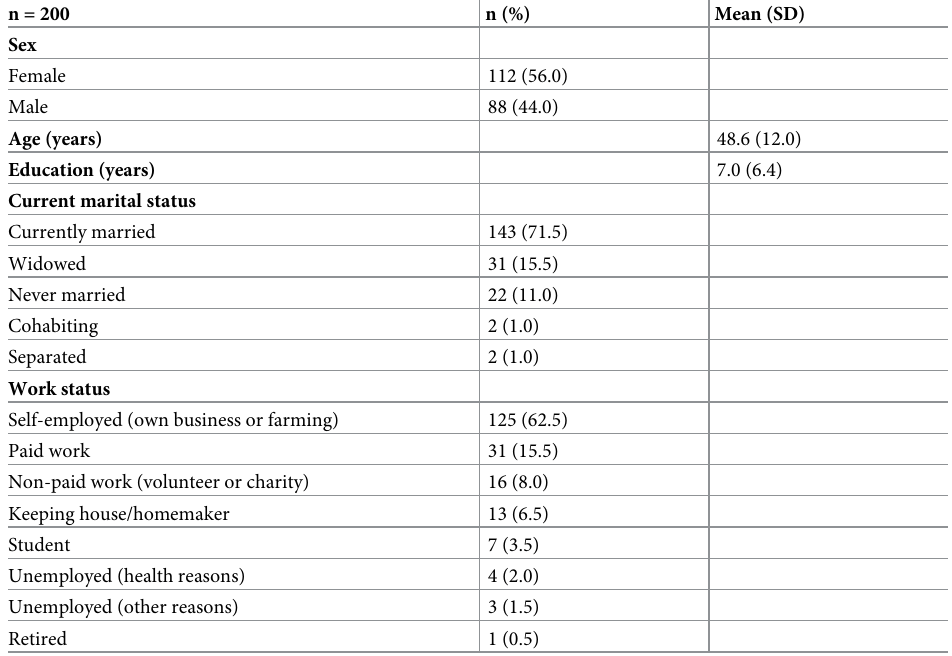
education. In Table 3, there are the 200 participants in the cross-sectional validity testing. The participants were all rural dwellers in Enugu state. Nearly equal numbers were males. They were middle aged with primary level of education. Most of them were married and self- employed. Table 3. Demographic characteristics of participants that participated in the cross-sectional validity testing.